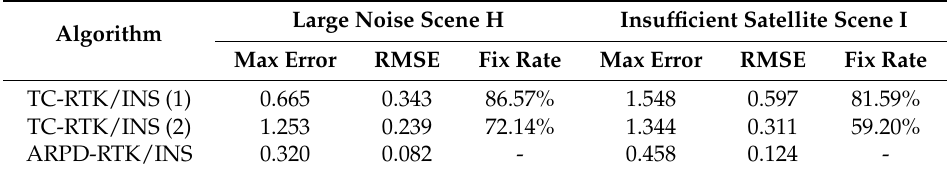
Table 6. Trajectory error and fix rate for different RTK algorithms on the real dataset (unit: